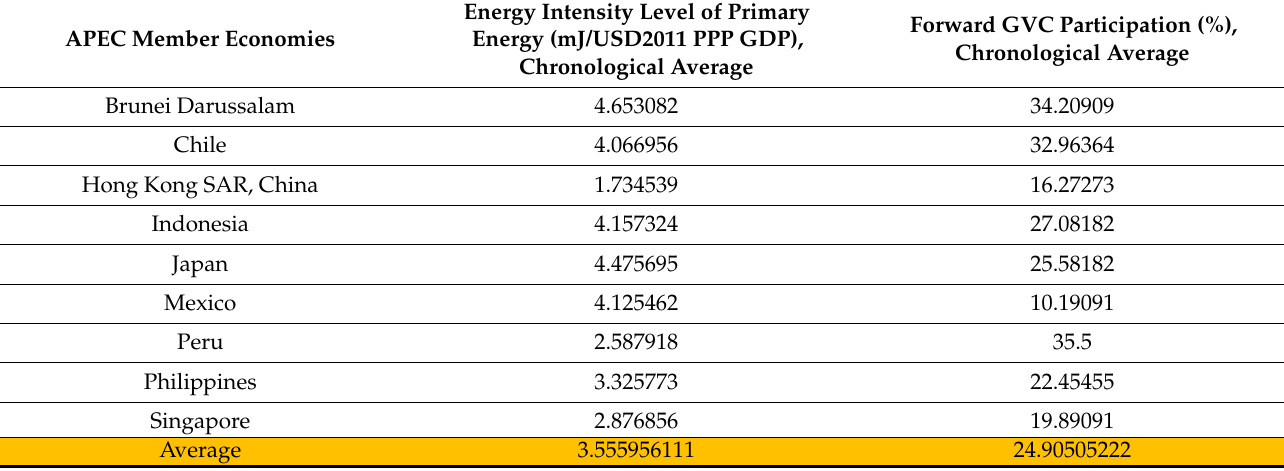
Table 15. APEC member economies with lower energy intensity level of primary